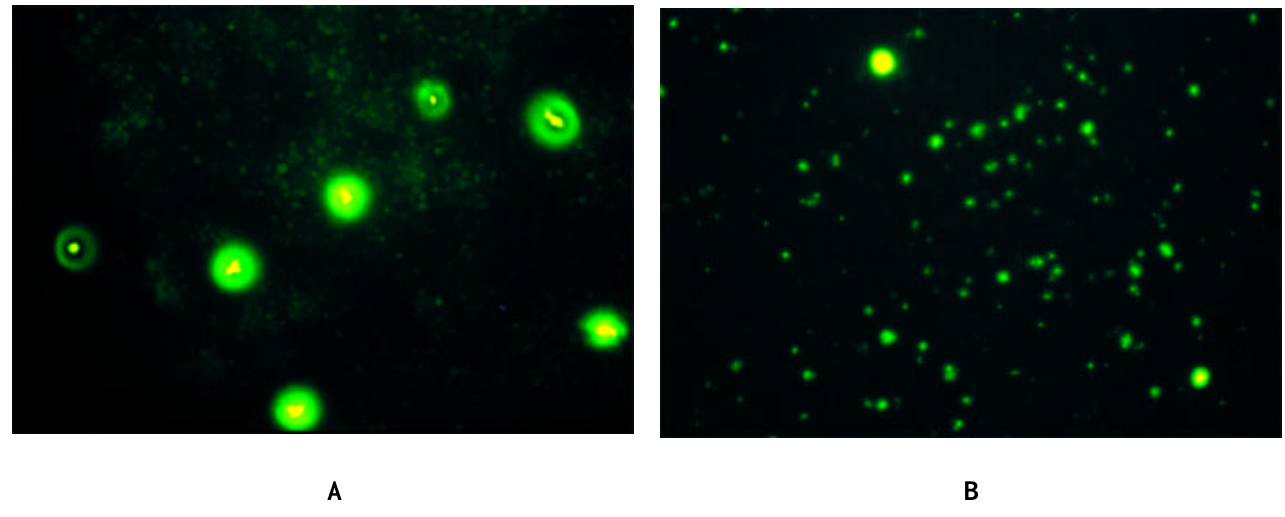
E2/2 to: A) SK-N-MC cells (Y 5 ). Binding of the antibody Y 5